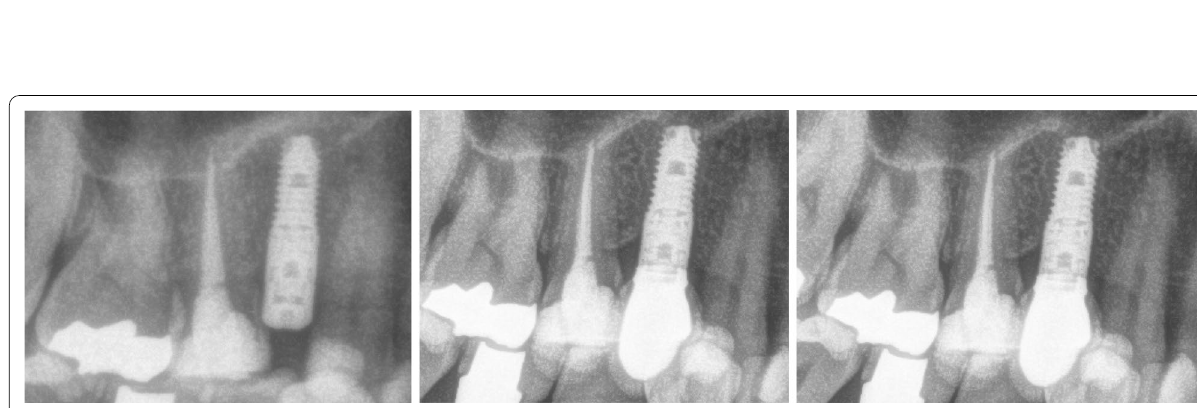
Fig. 2 Left : 8.5 length implant placed in #1.4 position. Center: 2 years later; single screw-retained crown over 2 mm. Straight transepithelial (intermediate abutment). Right: 6 years after implant placement. No marginal bone changes after 6-year follow-up